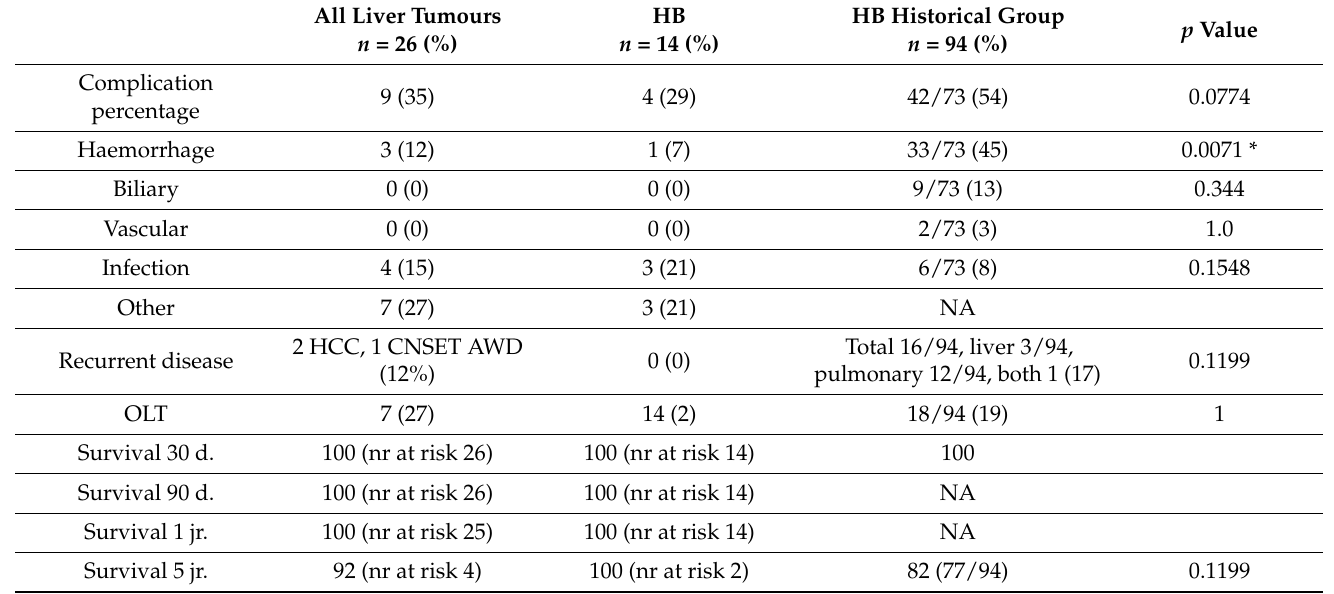
Table 4. Direct comparison between study cohort and historical cohort of HB in the